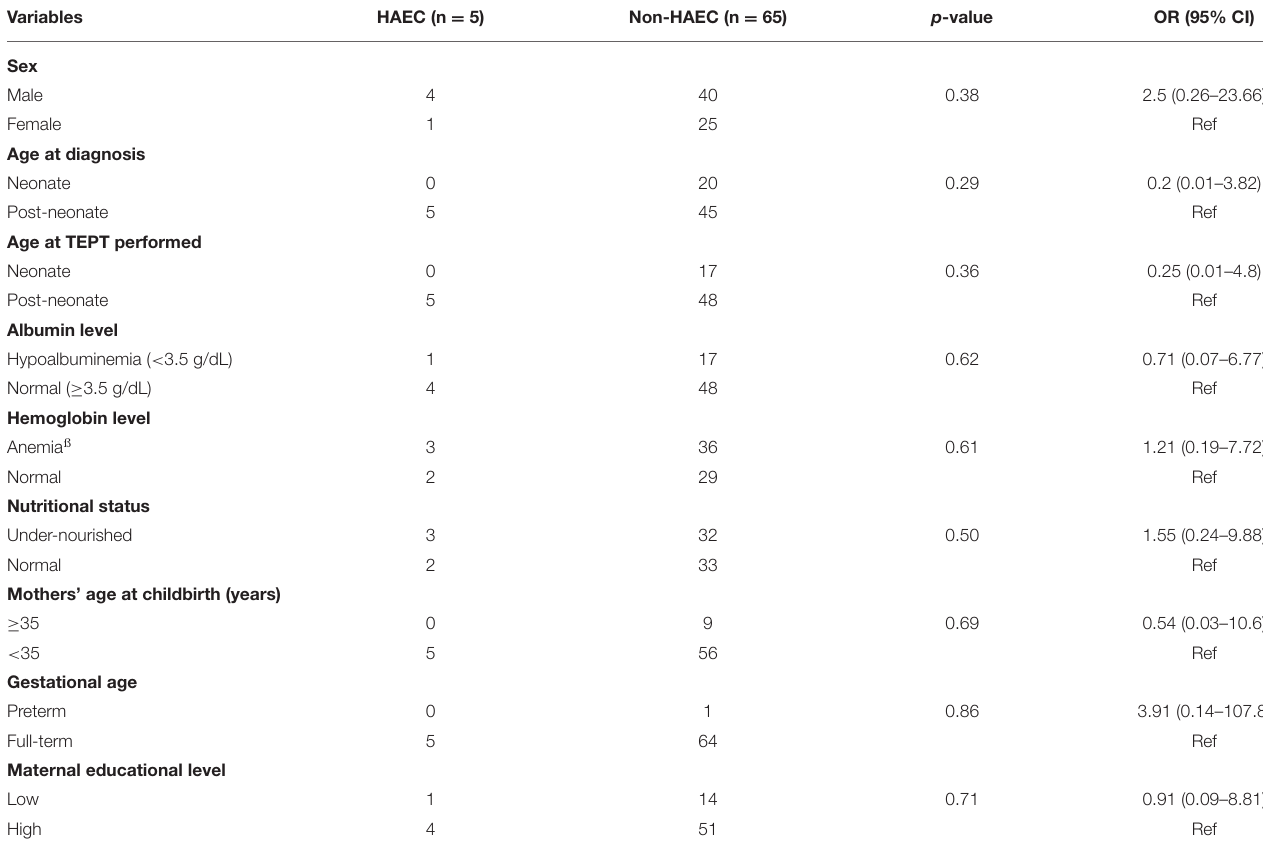
TABLE 4 | Association between risk factors and HAEC after TEPT using cut-off value of ≥ 10.